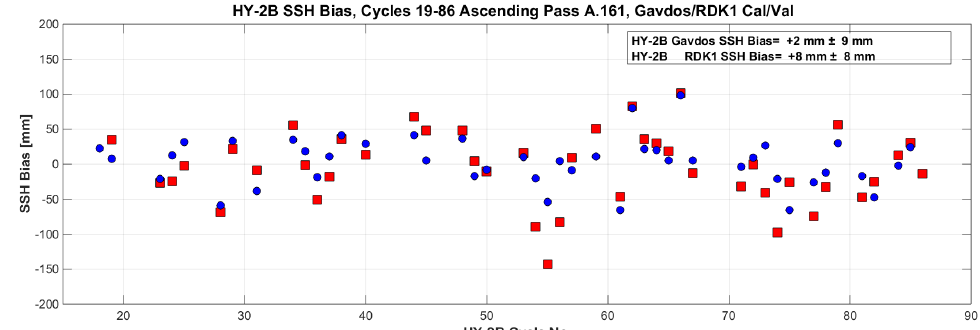
Figure 14. The HY-2B SSH bias as determined by the RDK1 (blue dots) and the Gavdos (red squares) Cal/Val sites using the same ascending Pass A161 south of Crete.